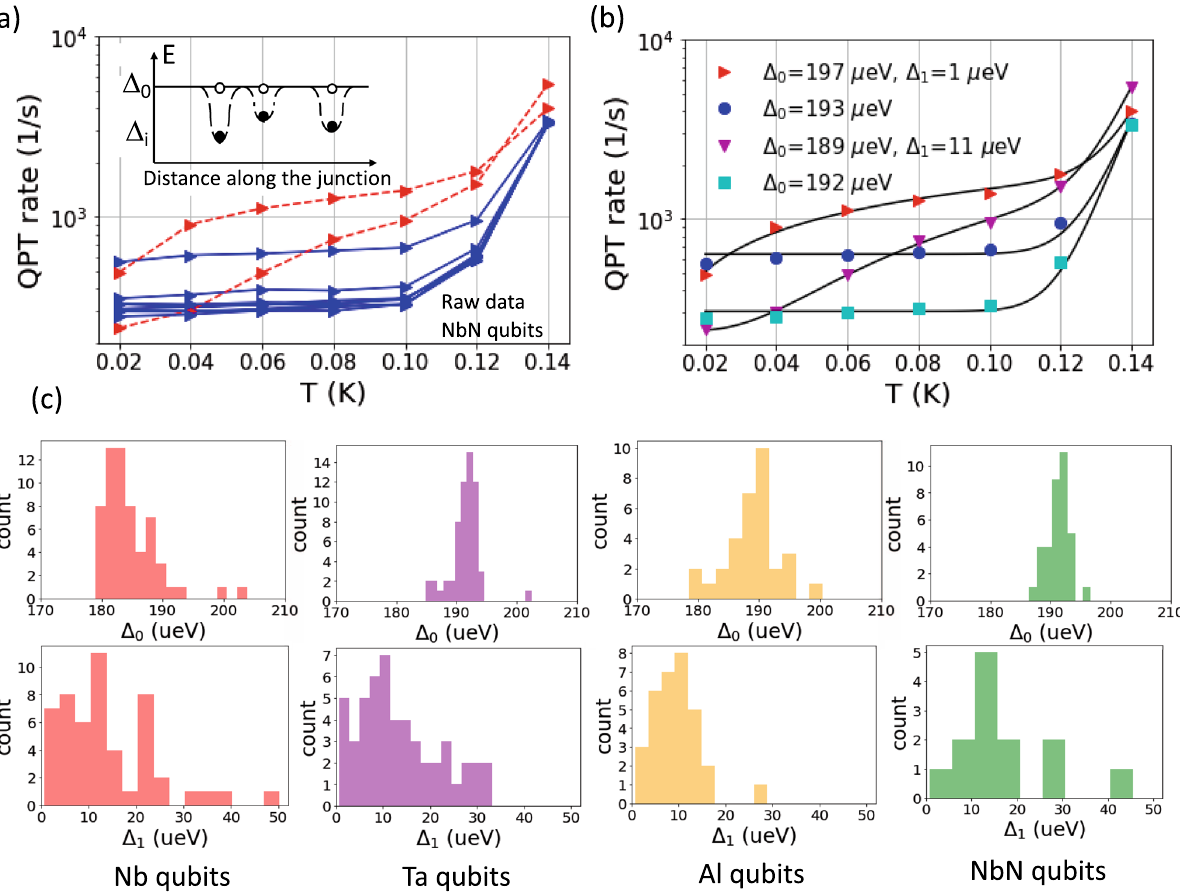
Fig. 4 Temperature dependence of QPT rate. a Raw data of QPT rate vs. temperature for ten transmons with NbN capacitor paddles (with design-E). The functional form of the temperature dependence shows signi fi cant variation despite they share the same fabrication conditions. Note the difference between red and blue curves. The inset is a cartoon illustrating the energy spectrum of a junction where the barrier has high transmission sites. b Fits (black curves) to the QPT rate vs. temperature data (colored markers) showing a good agreement and consistency of the inferred Al superconducting gaps from both models. c The histograms built from fi t parameters for various qubits with different type of paddle